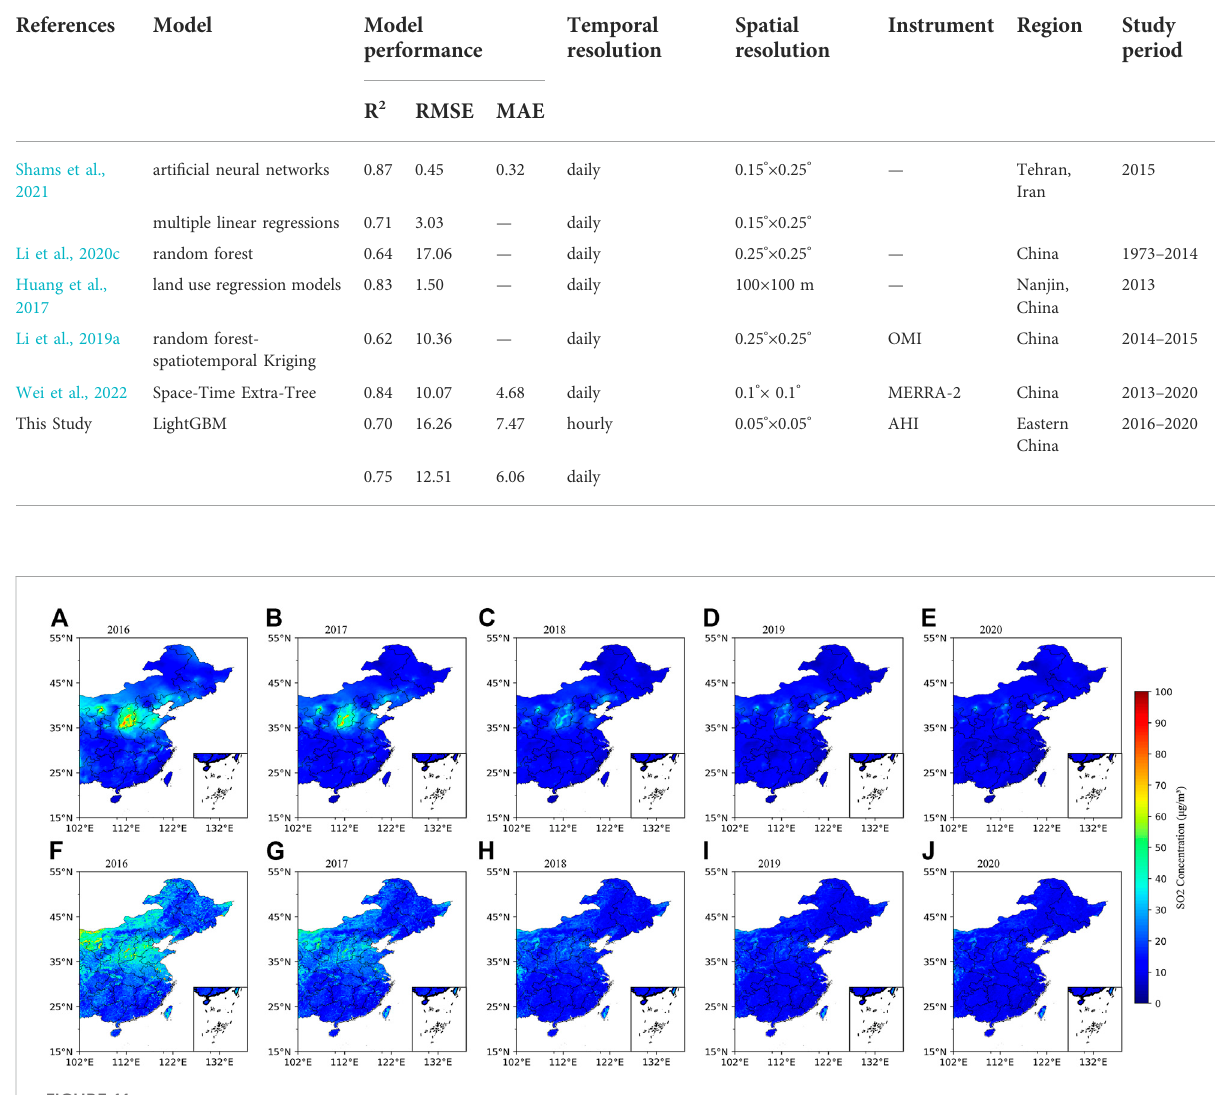
TABLE 5 Performance comparison of SO 2 model.